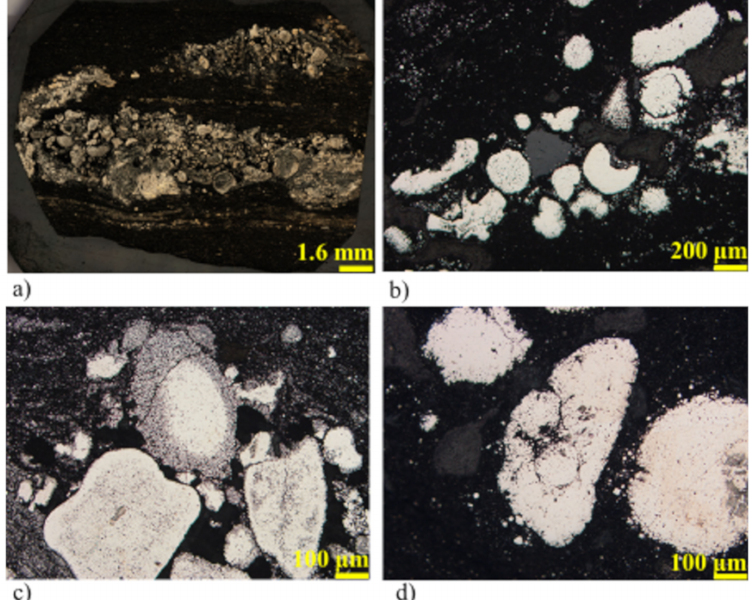
Figure 5. Photomicrographs under reflected light; ( a ) pyrite lag layer in a laser mount; ( b – d ) pyritic clasts within the lag layer.